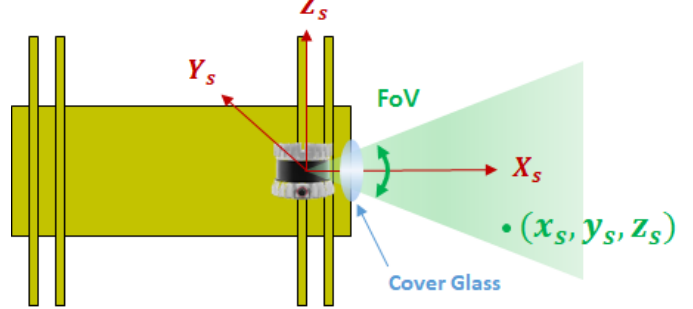
Figure 2. Illustration of PIG sensor frame